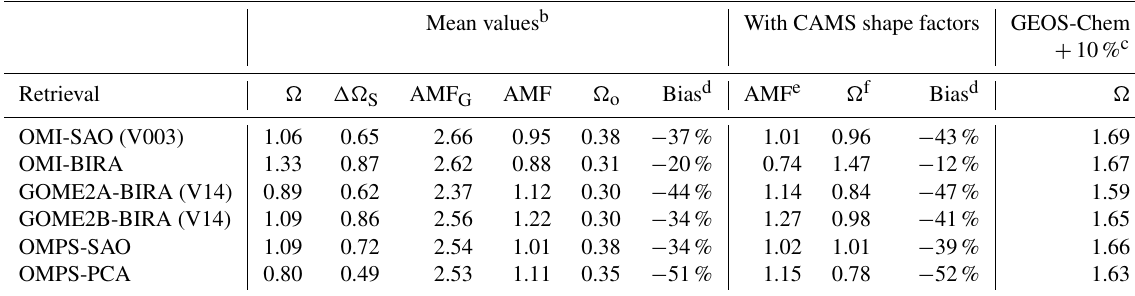
Table 3. Satellite retrievals of HCHO columns over the southeast US a .